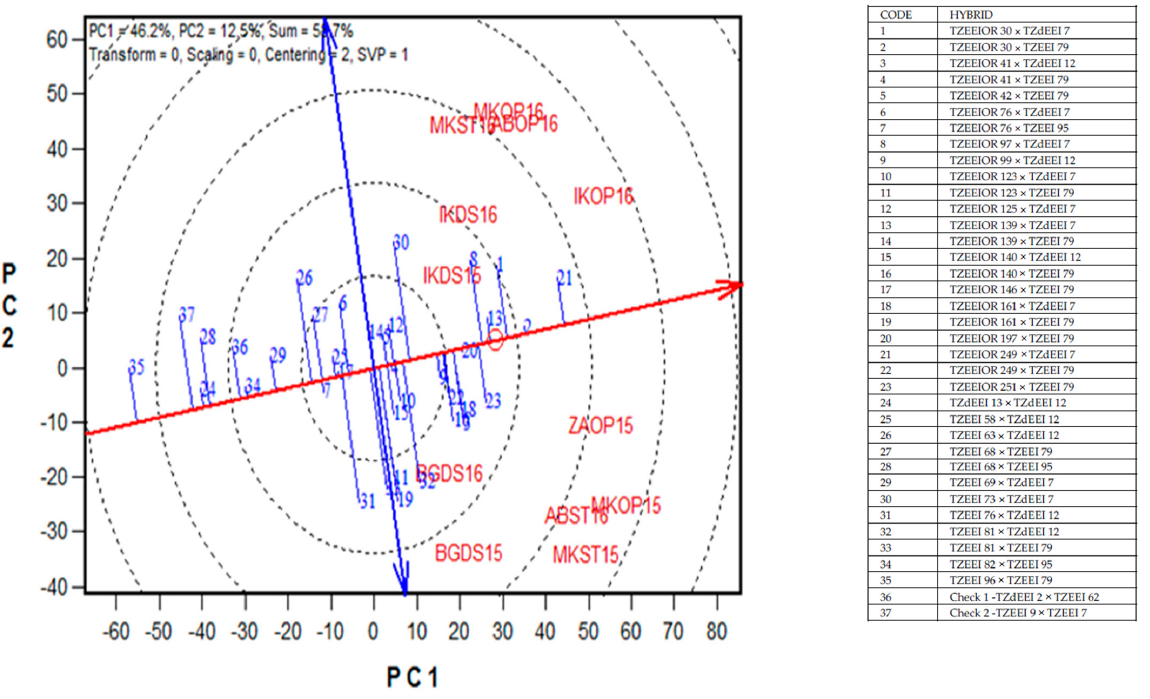
Figure 3. An entry/tester genotype plus genotype × environment interaction biplot of grain yield of 35 selected extra-early maturing PVA maize hybrids and two hybrid checks across stress and non- stress conditions in Nigeria, 2014–2016. ABOP16 = Abuja optimal, 2016; ABST16 = Abuja Striga - infested environment, 2016; BGDS15 = Bagauda drought stress, 2015; BGDS16 = Bagauda drought stress, 2016; IKDS15 = Ikenne drought stress, 2015; IKDS16 = Ikenne drought stress, 2016; IKOP16 = Ikenne optimal, 2016; MKOP15 = Mokwa optimal, 2015; MKOP16 = Mokwa optimal, 2016; MKST15 = Mokwa Striga -infested, 2015; MKST16 = Mokwa Striga -infested, 2016; ZAOP15 = Zaria optimal, 2015. 3. Discussion The presence of drought tolerance and Striga resistance/tolerance genes in PVA inbred lines TZEEIOR 97, TZEEIOR 41, TZEEIOR 30, TZEEIOR 140, TZEEIOR 109, and TZEEIOR 42, as well as elevated PVA levels ( ≥ 10 μ g·g − 1 ), indicated that the inbred lines could serve as invaluable sources of genes for developing stress-tolerant hybrids with superior levels of PVA. Furthermore, the PVA inbred lines could be reliable sources of beneficial alleles for the improvement of tropical maize germplasm for Striga resistance and elevated levels of PVA for introgression into tropical breeding populations. The highly significant genotypic mean squares observed for grain yield and other measured traits of the hybrids in the three test environments implied that there was adequate genetic dissimilarity among them to facilitate selection [33]. The significant differences observed among the mean squares for environments for most of the measured traits suggested that the environments were unique and effective in discriminating among the hybrids, thus justifying the need for testing hybrids in diverse environments before making valid conclusions [1]. The significant genotype × environment interaction effects for grain yield and other measured traits under optimal management conditions and Striga -infested environments revealed that the hybrids responded differently in varied environments. This confirmed the need for testing hybrids extensively across contrasting environments for many years to select outstanding genotypes for commercialization [16]. However, the lack of significant GEI effects for grain yield and other agronomic traits under drought implied that expressions of the traits were consistent in the drought